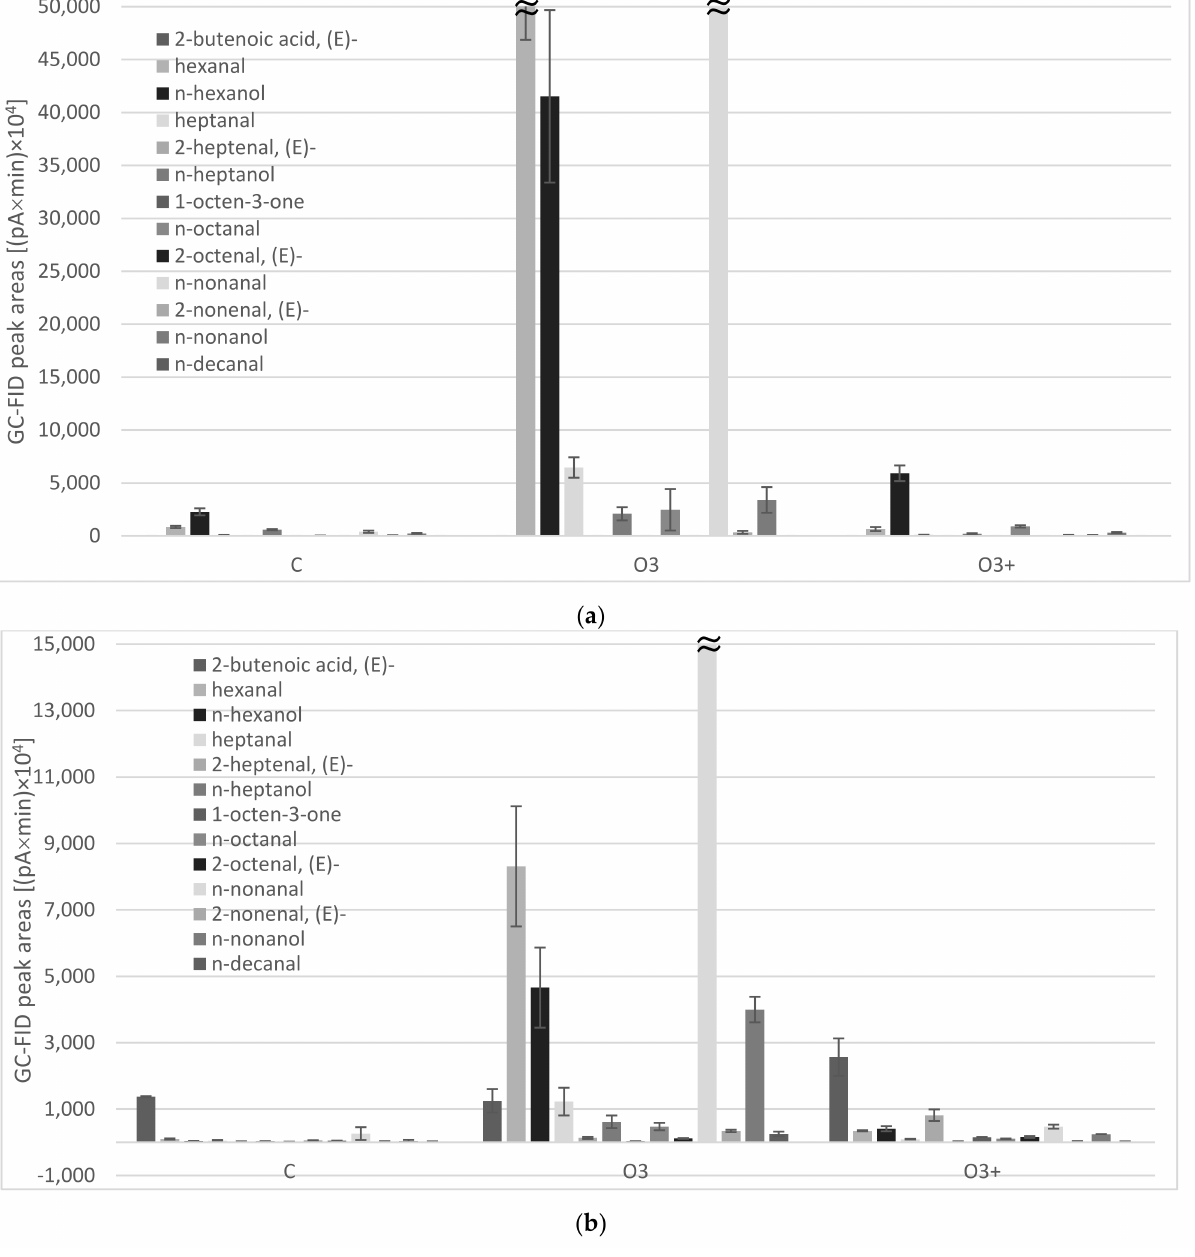
Figure 2. Volatile oxidation markers abundances as sampled by headspace solid-phase microextrac- tion and analyzed by GC-FID/MS: ( a ) ground pistachio kernels; ( b ) pistachio kernel oils obtained by cold solvent extraction. C = control (untreated samples), O 3 = samples treated using 10% DC (ozone level 300 ppm); O 3(+) = samples treated using 100% DC (ozone level 800